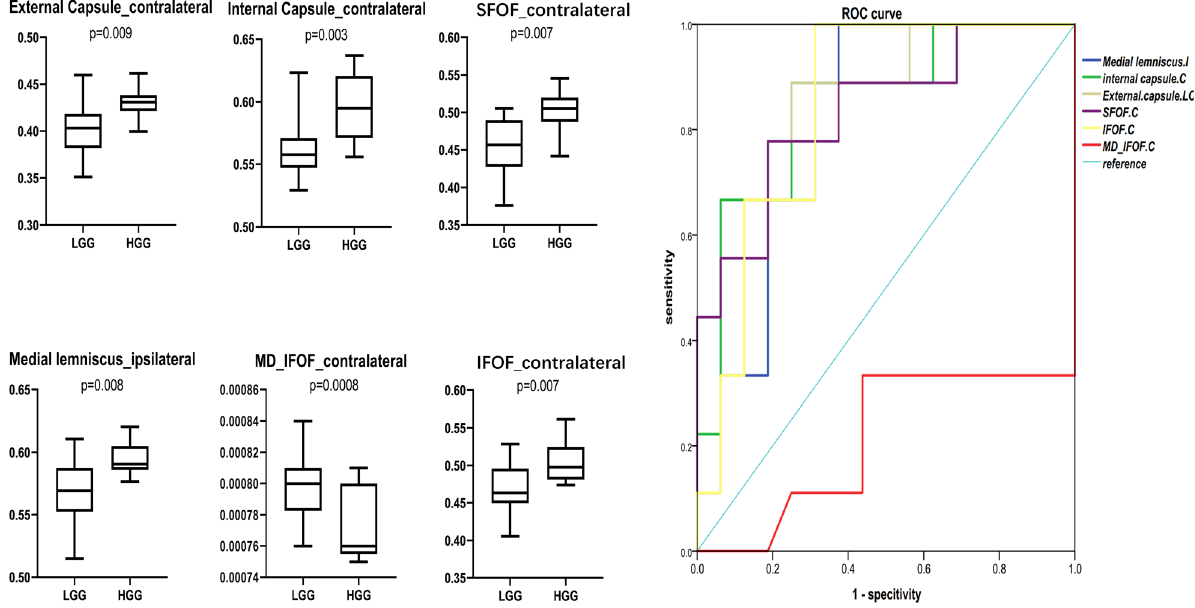
Figure 5. Clusters with significantly higher MD in LIG or RIG compared to the controls, identified by voxel- wise TBSS analysis. A: Left-sided axonal overlapping images of major crossovers (middle), as well as a 3-D rendered image (left). Bar graphs of the most common clusters are shown on the right. B: Right-sided axonal overlapping images of major crossovers (middle), as well as a 3-D rendered image (left). Bar graphs of the most common clusters are shown on the